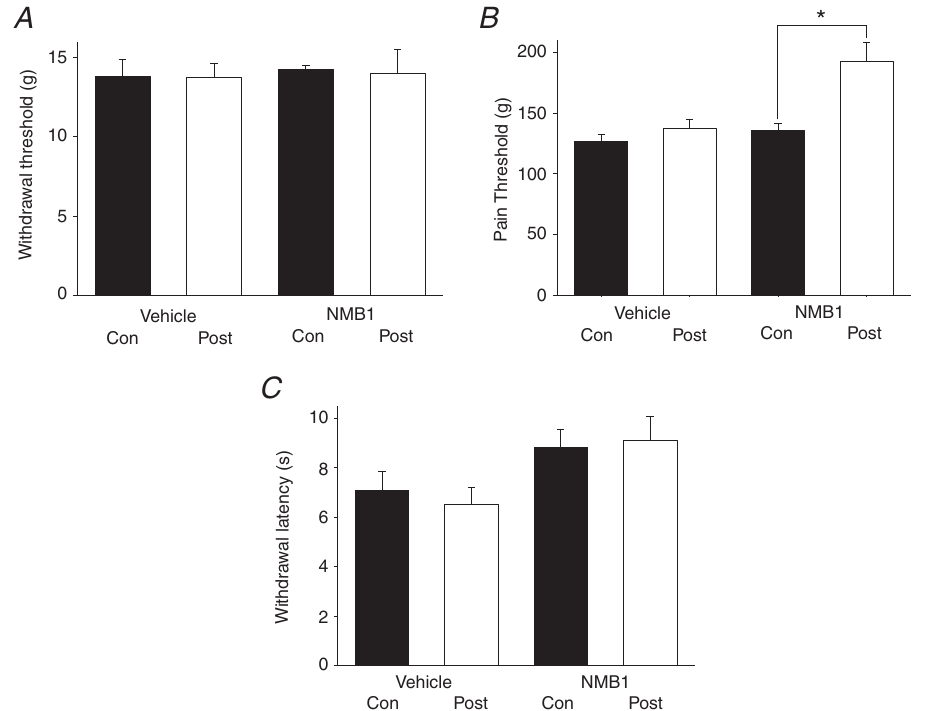
Figure 8. NMB-1 selectively inhibits behavioral responses to high intensity noxious mechanical stimuli. ( A ) The effect of NMB-1 on the 50% PWT in the von Frey test; data is shown as the percentage of post-injection values over pre-injection values. Neither NMB-1 (20 nMoles, n=8) nor its vehicle (0.1% BSA in external solution, n=8) had an effect on PWT. ( B ) NMB-1 (2 6 20 nMoles, n=8, Student’s unpaired t-test versus vehicle effect, P , 0.001) increased the threshold for evoking pain behaviors in rat hind paw by 41.1 6 7.3% in the Randall-Selitto test. Injection of 0.1% BSA solution had no behavioral effects (n=8). ( C ) NMB-1 had no effect on withdrawal latencies in the Hargreaves’ test for thermal sensitivity; after injection of 20 nMoles of NMB-1 latencies were 107.5 6 16.6% of pre-injection control values (n=6 in each group, Student’s paired test; P . 0.8; Student’s unpaired t-test versus vehicle effect, P . 0.4).